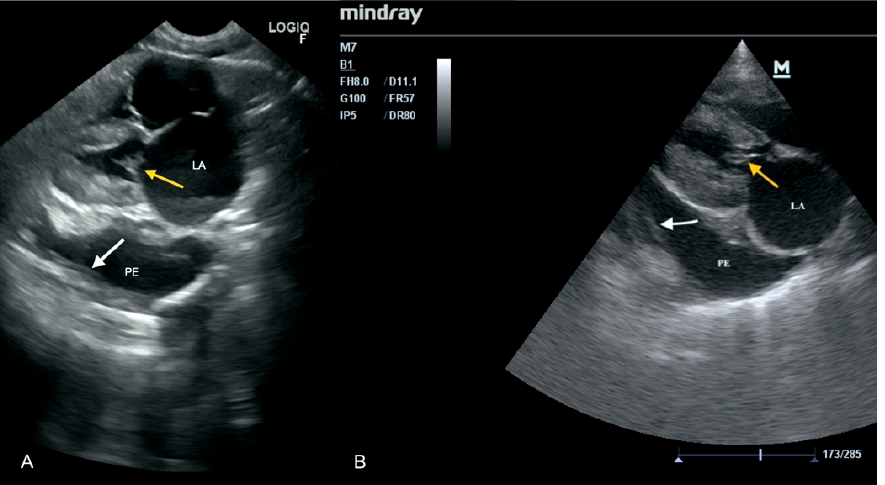
Figure 2. Vegetations on the anterior leaflet of the mitral valve (yellow arrow), enlarged left atrium (LA), and pericardial effusion (PE); the white arrow points to the percicardial sac. ( A ) Scan from a microconvex probe obtained during focused cardiac ultrasound examination (GE Healthcare Logiq F6). ( B ) Scan from a phased array probe obtained during echocardiography examination performed by a board-certified echocardiography specialist (Mindray M7).